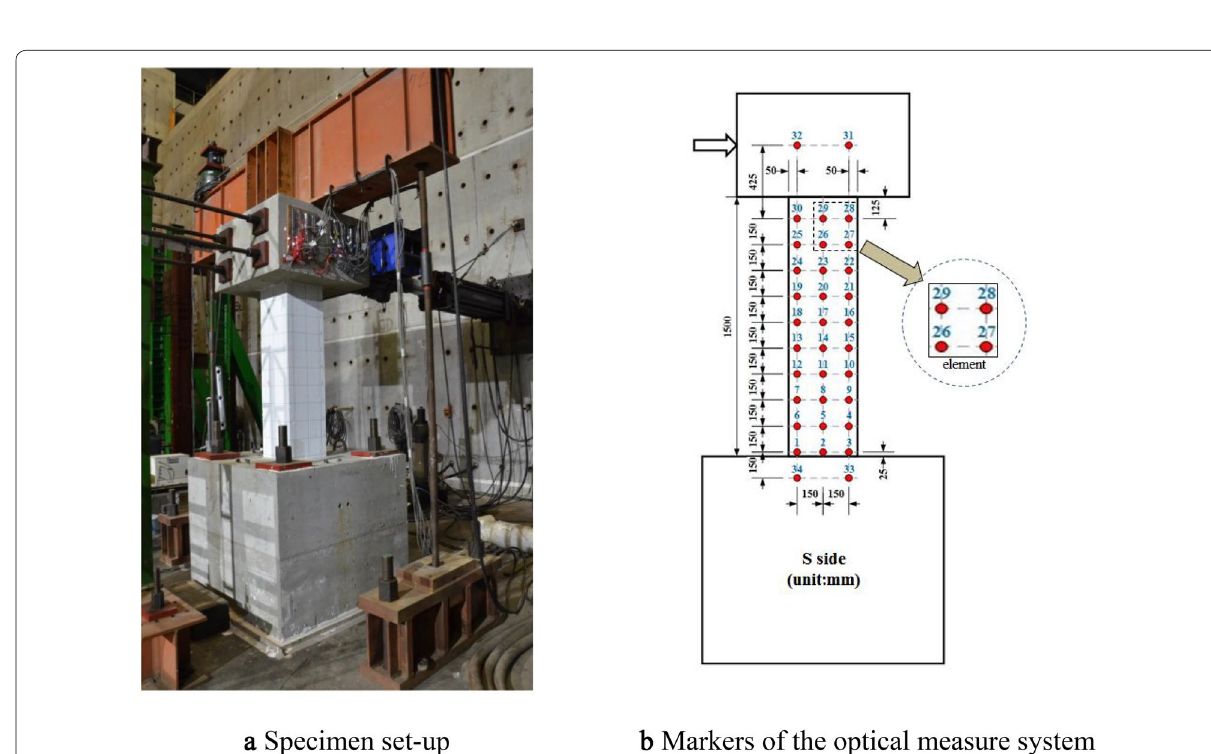
Fig. 5 Column specimens with the single